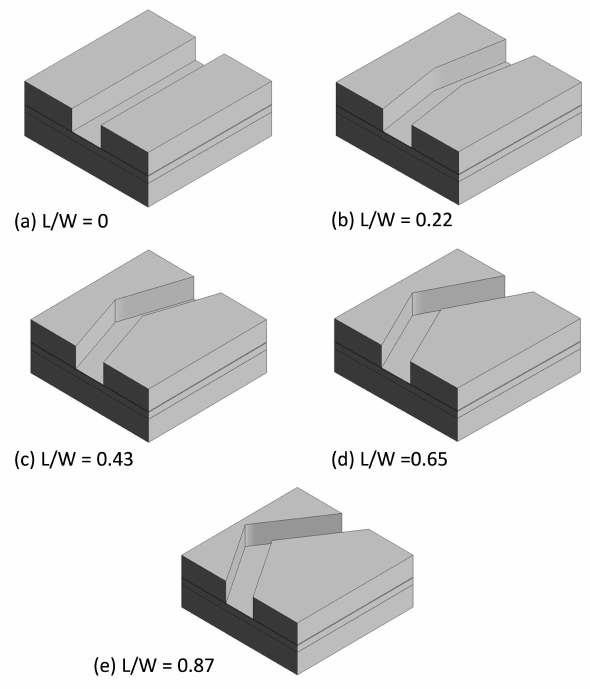
Figure 2. ( a – e ) Shows that various shapes of microvalve fluid domain model illustrated with length/width (L/W)